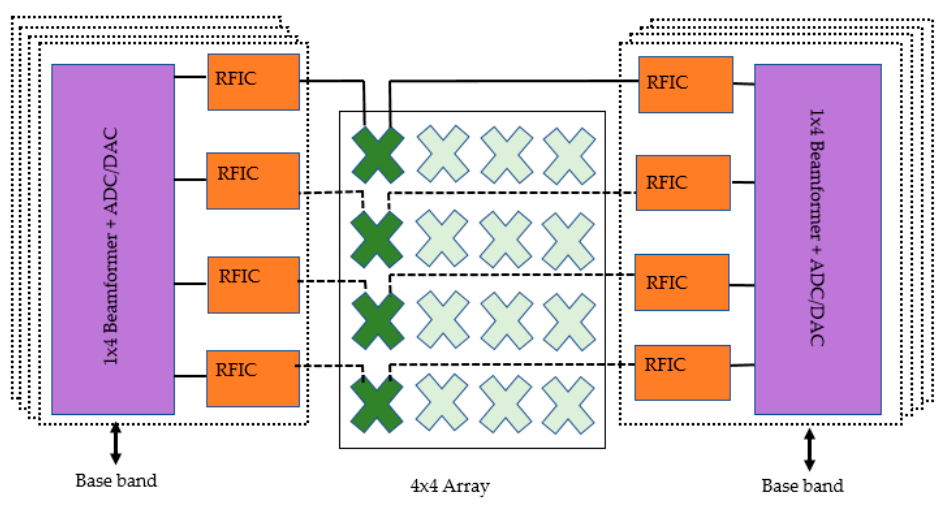
Figure 13. Components of a 4 × 4 Tx/Rx dual polar mMIMO configuration.